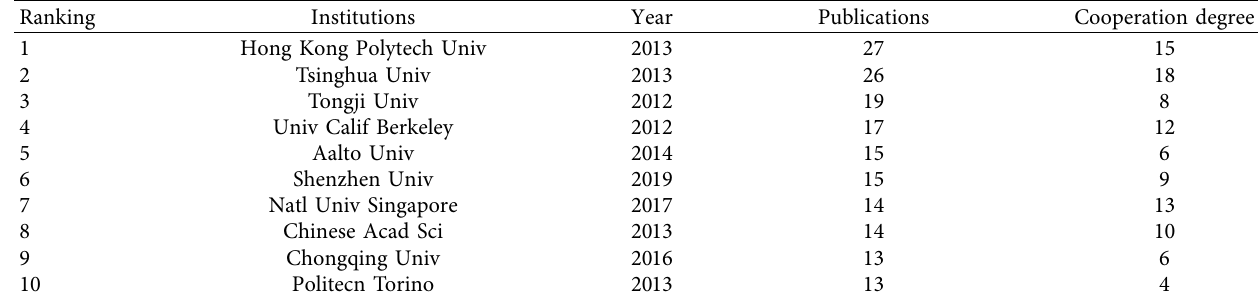
Figure 3: Organization collaboration network. Table 1: Te top 10 institutions with high